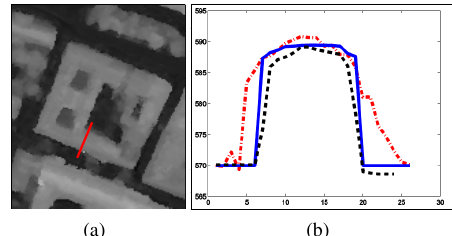
Figure 2: (a) The slice of the sample building where the hight values are taken. (b) Red dashed profile represents original WV2 DSM values, black dashed profile represents the LIDAR DSM values, blue continues line represents automatically obtained re- construction values by using WV2